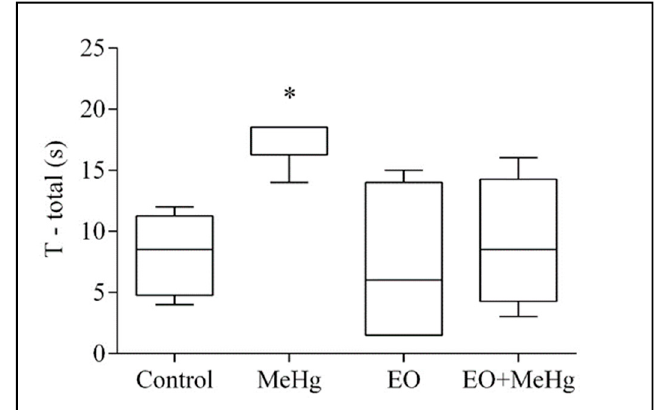
Figure 3. Euterpe oleracea consumption totally prevents the alterations caused by methylmercury in the time to descend (latency) in the pole test. Mice were treated with clarified E. oleracea juice (EO) once a day for 8 days and/or methylmercury (MeHg) for 4 days. Data are presented as median and interquartiles ( n = 8–10). * P < 0.05 vs all groups.